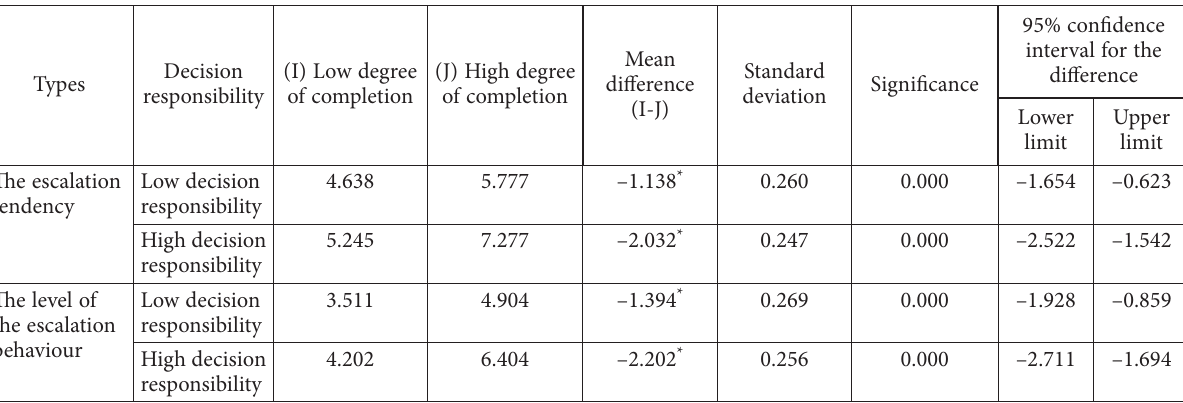
Table 5. EOC of investors in PPP projects: comparison in pairs 2